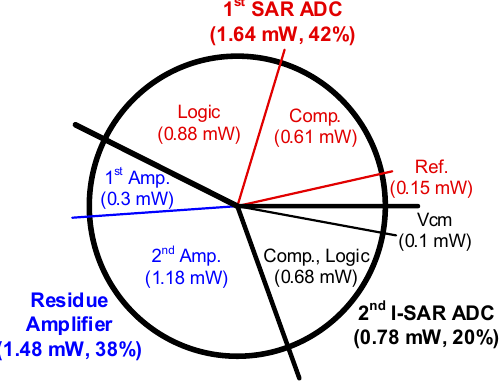
Figure 16. Power breakdown. Figure 16. Power